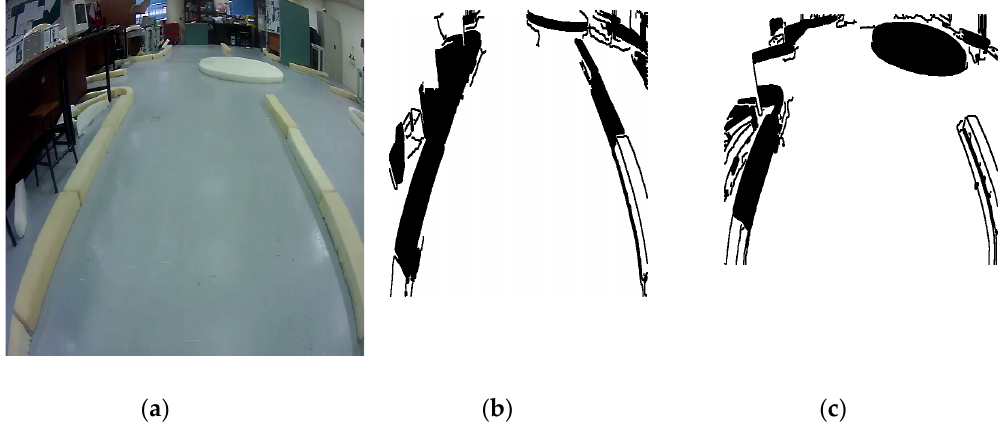
Figure 23. Camera sequence images: ( a ) original image when the WMR starts moving, ( b ) camera’s local